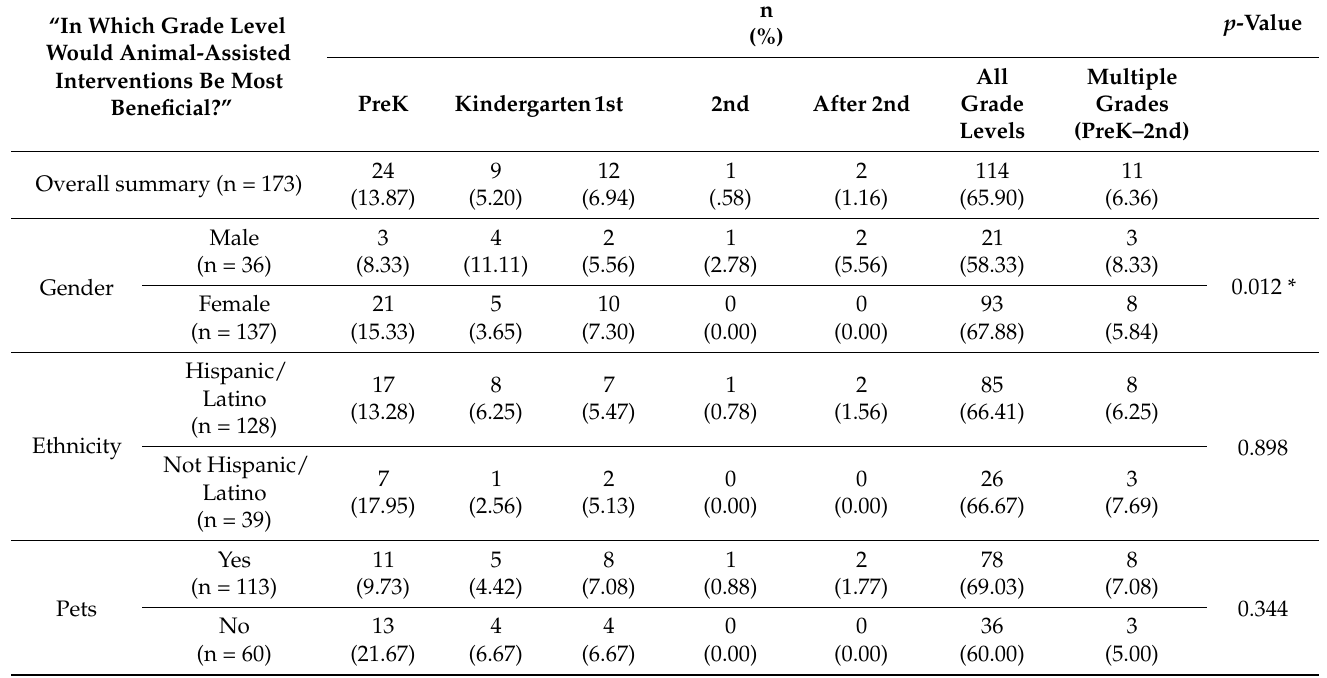
Table 3. School grade perceived to be ideal for AAIs—overall, by gender, ethnicity, and pet ownership. “In Which Grade Level